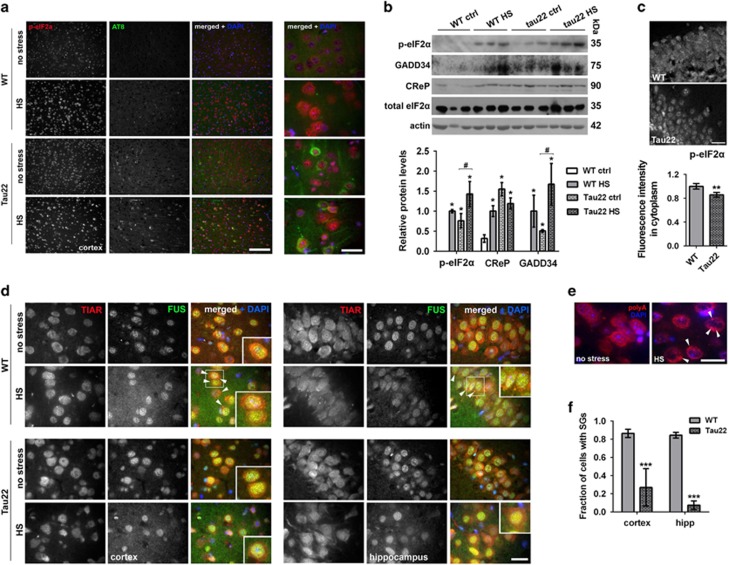
Transgenic mouse model of tauopathy is characterized by elevated basal p-eIF2α levels and impaired SG assembly in the brain. (a) p-eIF2α immunoreactivity is increased in the cortex of 8-month-old Tau22 transgenic animals compared with age-matched wild type (WT) controls under normal conditions and after HS. AT8 antibody was used to visualize phospho-tau on sagittal brain sections. (b) Levels of p-eIF2α, CReP and GADD34 proteins are higher in the hippocampus (CA1 subfield) of Tau22 animals compared with age-matched WT control animals (WT ctrl) and are upregulated by HS. Representative western blots and band intensity quantitation are shown (* and #P≤0.05, asterisks indicate significant difference as compared with naive WT animals). For all proteins, band intensity for WT animals after HS was taken as equal 1. (c) Decreased p-eIF2α intensity in the cytoplasm of hippocampal neurons of Tau22 mice after HS. Representative images of p-eIF2α staining are shown for the same animals as in a. Details of fluorescence intensity analysis are given in Materials and methods section (**P<0.01). (d-f) Efficient HS-induced SG assembly is observed in cortical and hippocampal neurons of WT mice but not in Tau22 animals. SGs (arrowheads) were visualized using anti-TIAR antibody (d) or RNA-FISH with a fluorescently labeled poly(dT) probe (e); in (d), co-staining with an anti-FUS antibody in was used to highlight nuclei. For quantification of SG-containing cells, >100 neurons were assessed in each of the studied regions in three HS-treated mice per genotype (***P<0.001) (f). Scale bars, (a) 200 μm; (c)20 μm; (d, e) and inset in (a) 10 μm